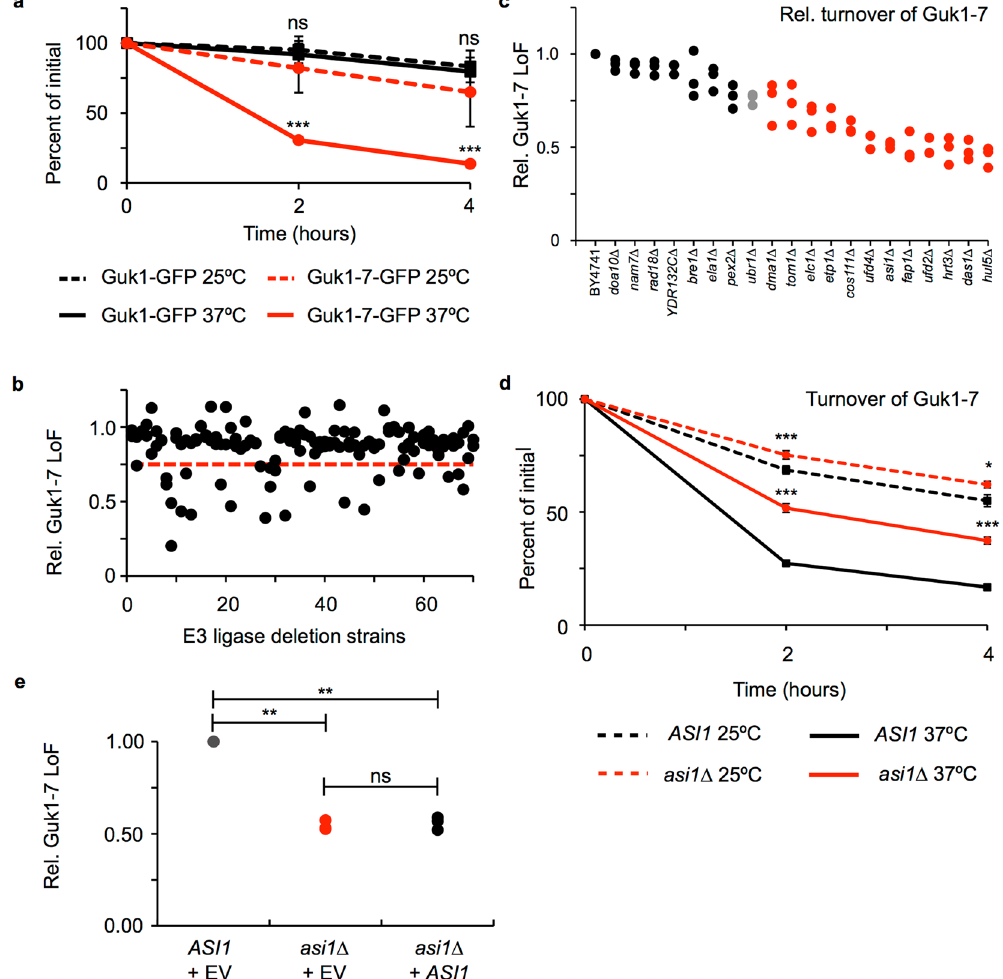
Figure 1. Flow cytometry based screen for E3 ligases targeting Guk1-7-GFP for degradation. ( a ) Wild type cells expressing ectopic Guk1-GFP or Guk1-7-GFP were incubated with CHX for 4 hours at 25°C or 37°C and samples were collected at the indicated time points. Results represent the mean and standard deviation of three independent experiments. ( b ) Seventy non-essential E3 ligase deletion strains expressing Guk1-7-GFP were incubated with CHX at 25°C or 37°C for 2 hours and then analyzed by flow cytometry. Red line demarks strains with a relative loss of fluorescence (Rel. LoF) value of 0.75 or lower. ( c ) The top 20 strains were selected for further validation by flow cytometry with experiments performed as in ( b ). Data points in red correspond to strains displaying Guk1-7-GFP stabilization levels higher than that of ubr1 ∆ . ( d ) Wild type or asi1 ∆ cells expressing Guk1-7-GFP were incubated with CHX at 25°C or 37°C for two hours prior to flow cytometry analysis. Results represent the mean and standard deviation of three independent experiments. ( e ) Wild type and asi1 ∆ cells co-expressing Guk1-7-GFP and an empty vector (EV) or ASI1 were treated as in ( d ). ns, * , ** and *** denote: not significant, p < 0.05, 0.01, and 0.005,